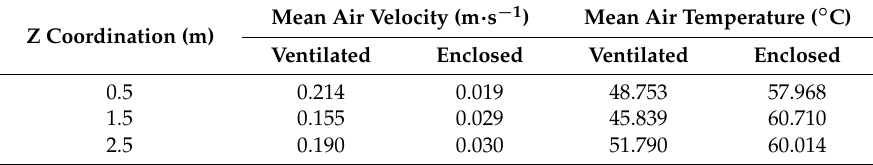
Table 5. Mean air temperatures and velocities on different air cross